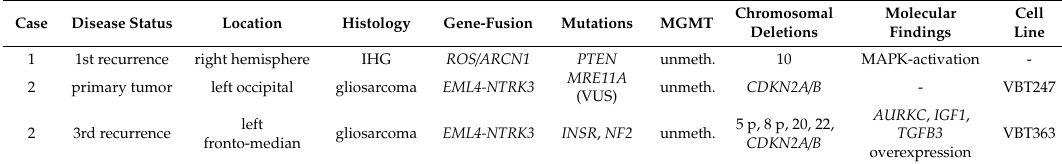
Table 1. Histopathologic, molecular characteristics and next-generation sequencing.